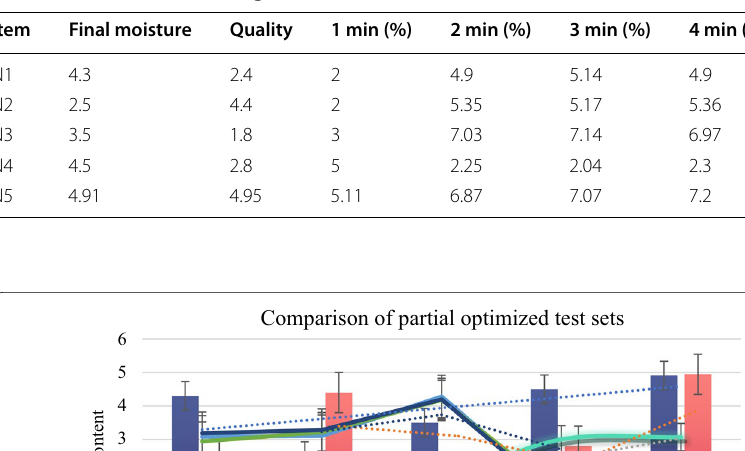
Table 9 Number of training results for verification test set